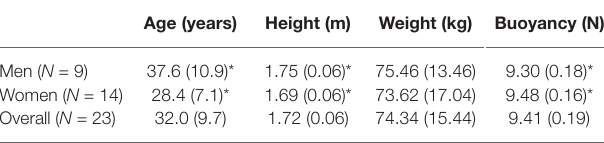
TABLE 2 | Mean participant characteristics